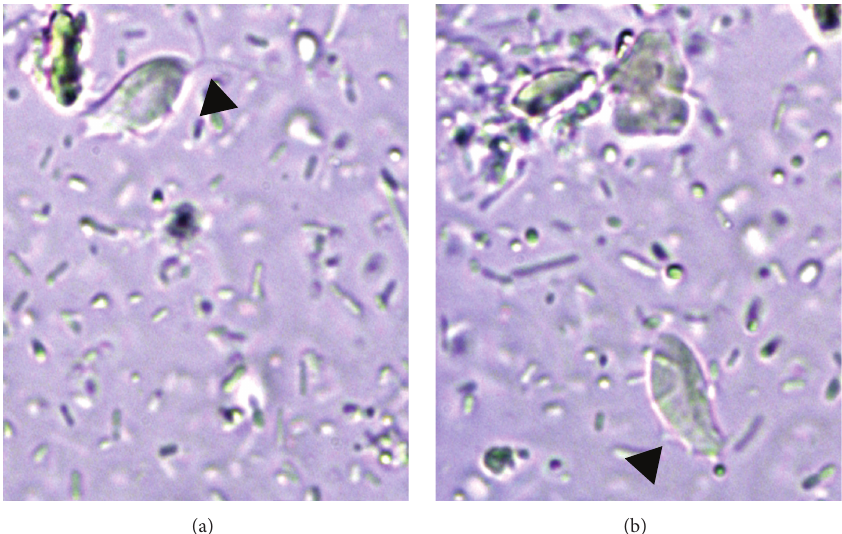
Figure 3: Typical morphology of trichomonads observed in saline solution-diluted fresh fecal smear from the cat with diarrhea. Arrow heads in (a) and in (b) indicate anterior flagella and undulating membrane, respectively (630x).